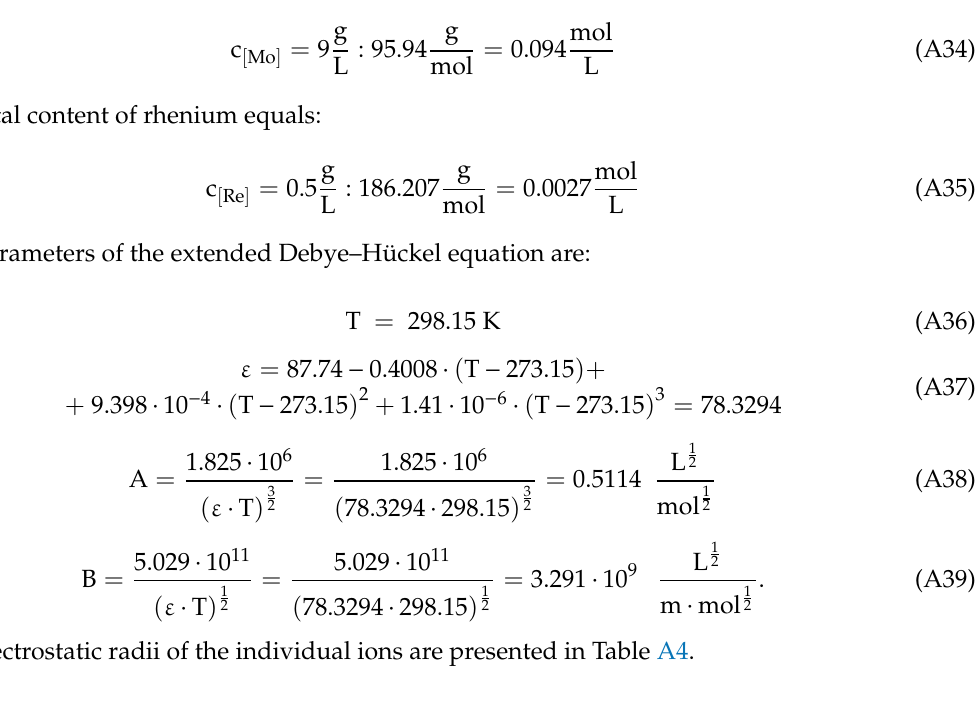
Table A4. Electrostatic radii of individual